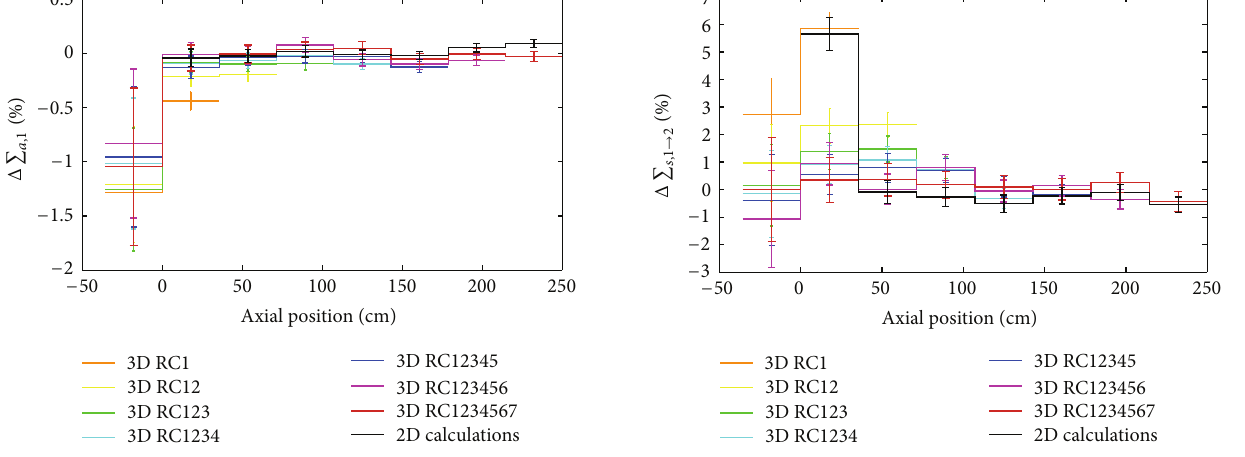
Figure18:Relativedifferencesbetweenabsorptioncrosssectionsfor the fast group.